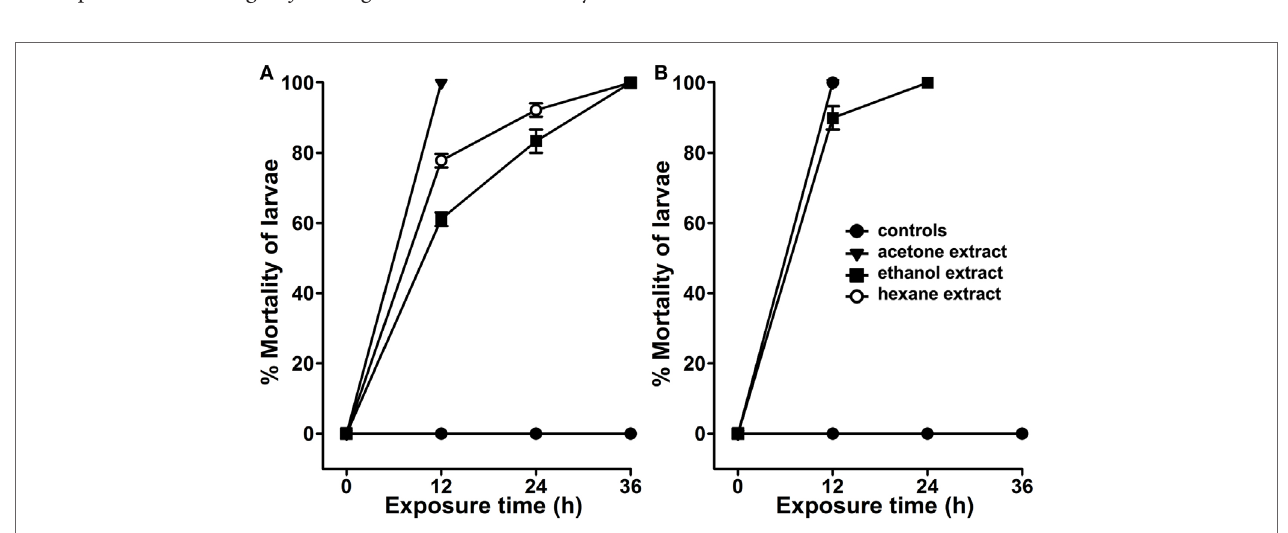
FigUre 2 | larvicidal activity in the organic extracts of Agave . The extracts of Agave angustifolia leaves were prepared in different organic solvents, such as acetone, ethanol, or hexane. (a) A. aegypti or (B) C. quinquefasciatus larvae were treated with 100 ppm dose of these organic extracts separately. The percentage of larval mortality in each extract exposure was calculated against the sham-treated controls and represented as the mean ± SD of